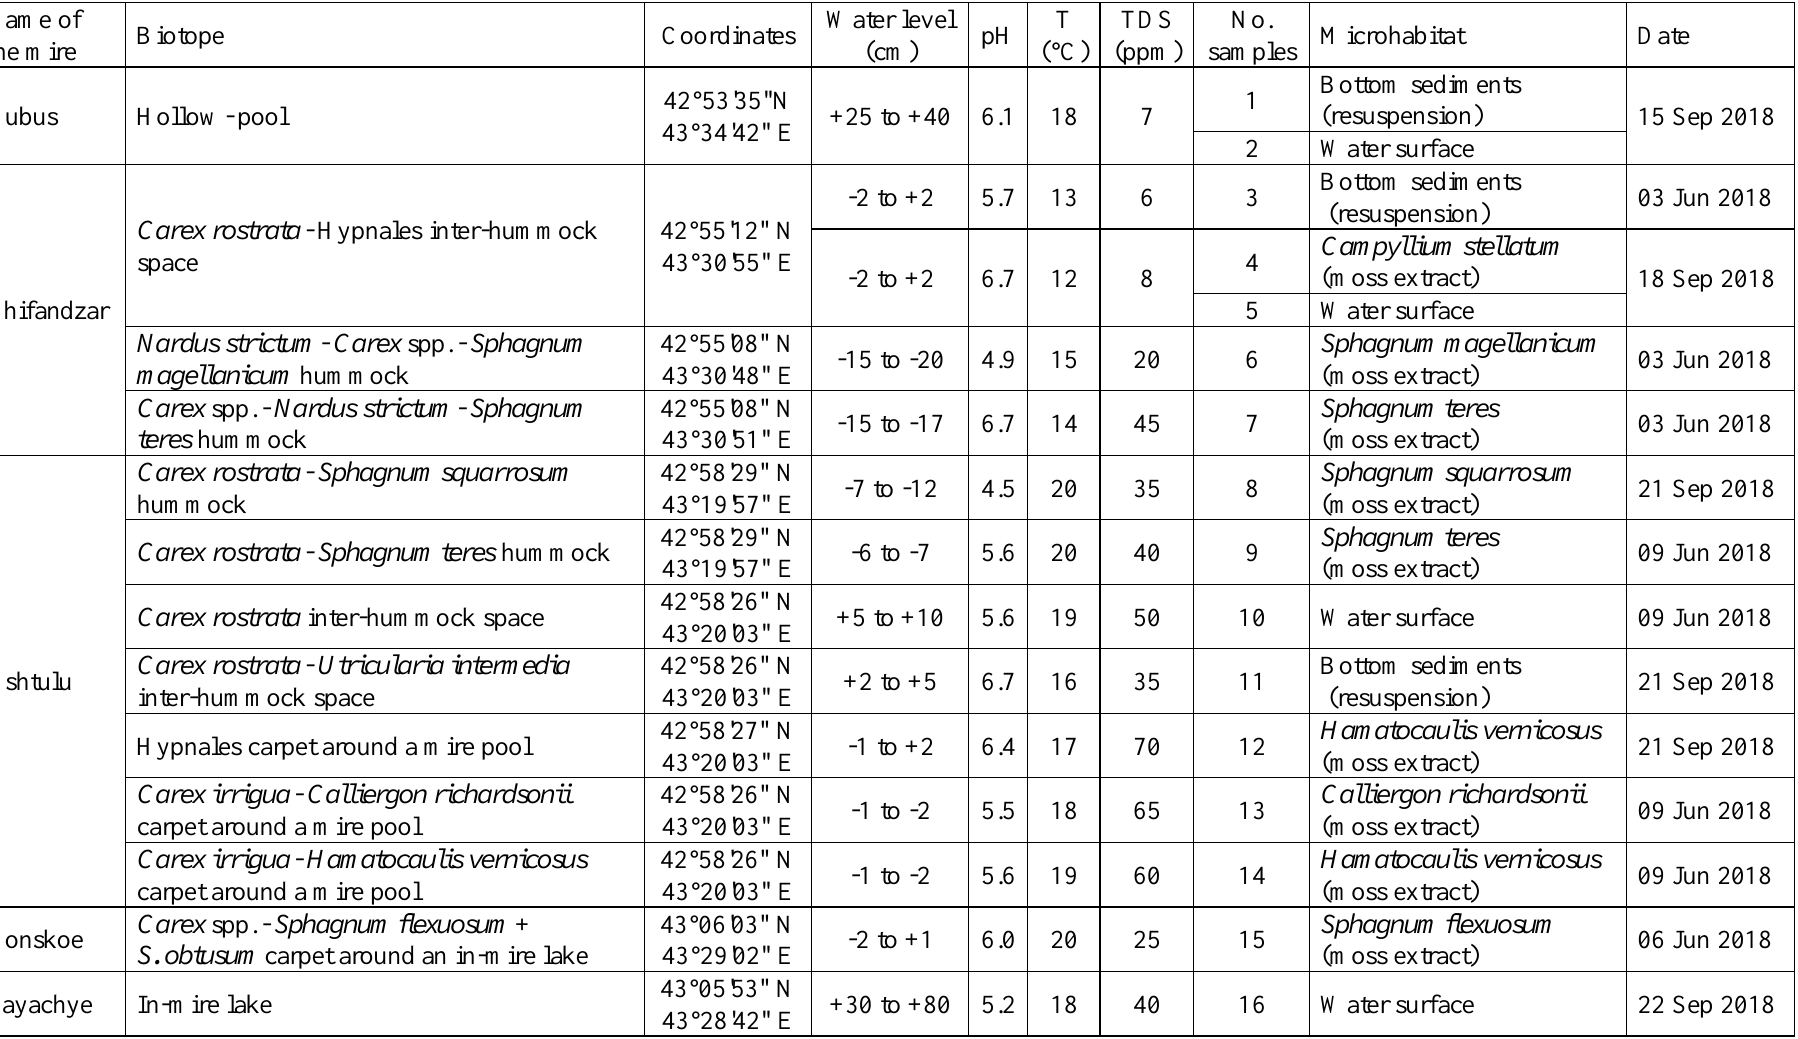
Table 1. Characteristics of the studied mires. Name